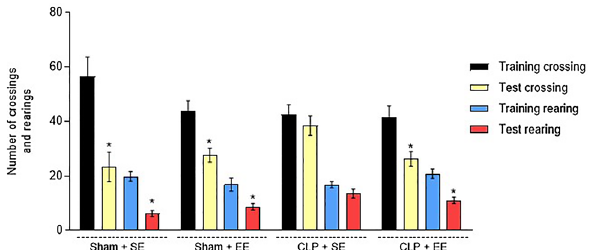
Figure 7. Behavioral test of exploratory and locomotor activity after the environmental enrichment protocol in animals submitted to sepsis. The bars represent mean ± SEM, the statistical difference being calculated using the Student T test for independent samples. nº = 10 each group. * p < 0.05 when comparing the test versus training of your own group. EE: environmental enrichment; SE: standard environment.